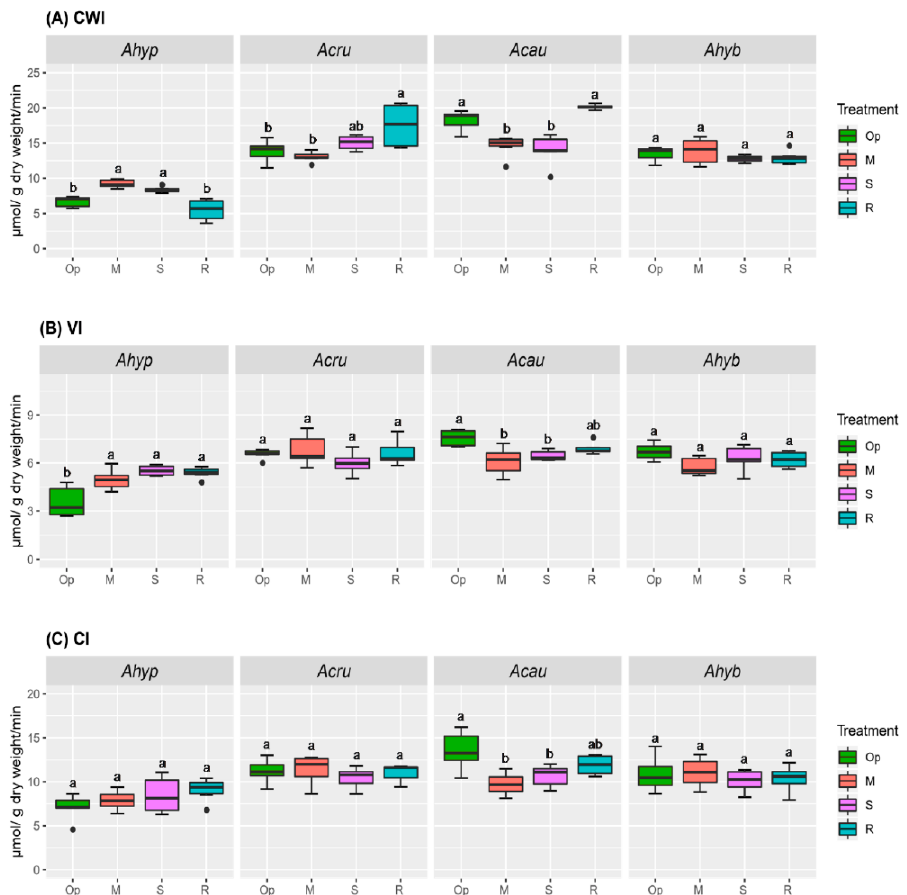
Figure 4. Invertase activity in roots of amaranth plants subjected to water-deficit stress. ( A ) Cell wall invertase [CWI], ( B ) vacuolar invertase [VI], and ( C ) alkaline/neutral cytoplasmic invertase [CI] activities in roots of Amaranthus hypochondriacus (Ahypo), A. cruentus (Acru), A. caudatus (Acau), and A. hybridus (Ahyb) plants growing in optimal conditions (Op), subjected to moderate (M) or severe (S) water-deficit stress, or allowed to recover from S, one day after normal watering was restored (R). Different letters over the box-and-whisker plots represent statistically significant differences at p ≤ 0.05 (Tukey Kramer test; n = 9). Box-and-whisker plots show high, low, and median values. The results shown are those obtained from a representative experiment that was repeated in the spring-summer and summer-autumn seasons of 2015, respectively, with similar results.